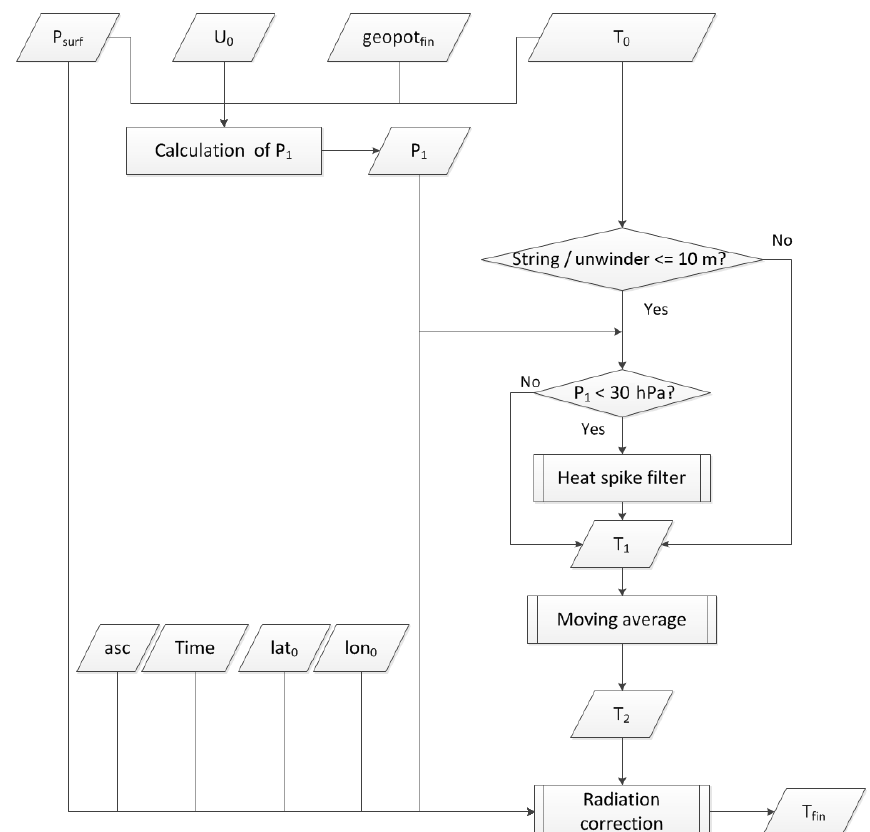
Figure 2. GRUAN data processing flow for RS-11G temperature measurement (excerpt from Kizu et al., 2018). T 0 and U 0 represent un- corrected temperature and RH, respectively, P surf is surface pressure, lat 0 and lon 0 are the initial data set of GPS latitude and longitude, respectively, geopot fin is the final geopotential height as derived from GPS altitude and latitude, asc is the ascent rate, and T fin is the cor- rected final temperature value. Parallelograms, rectangles, diamonds, and rectangles with double vertical lines indicate input or output data, processes, decisions, and correction processes,